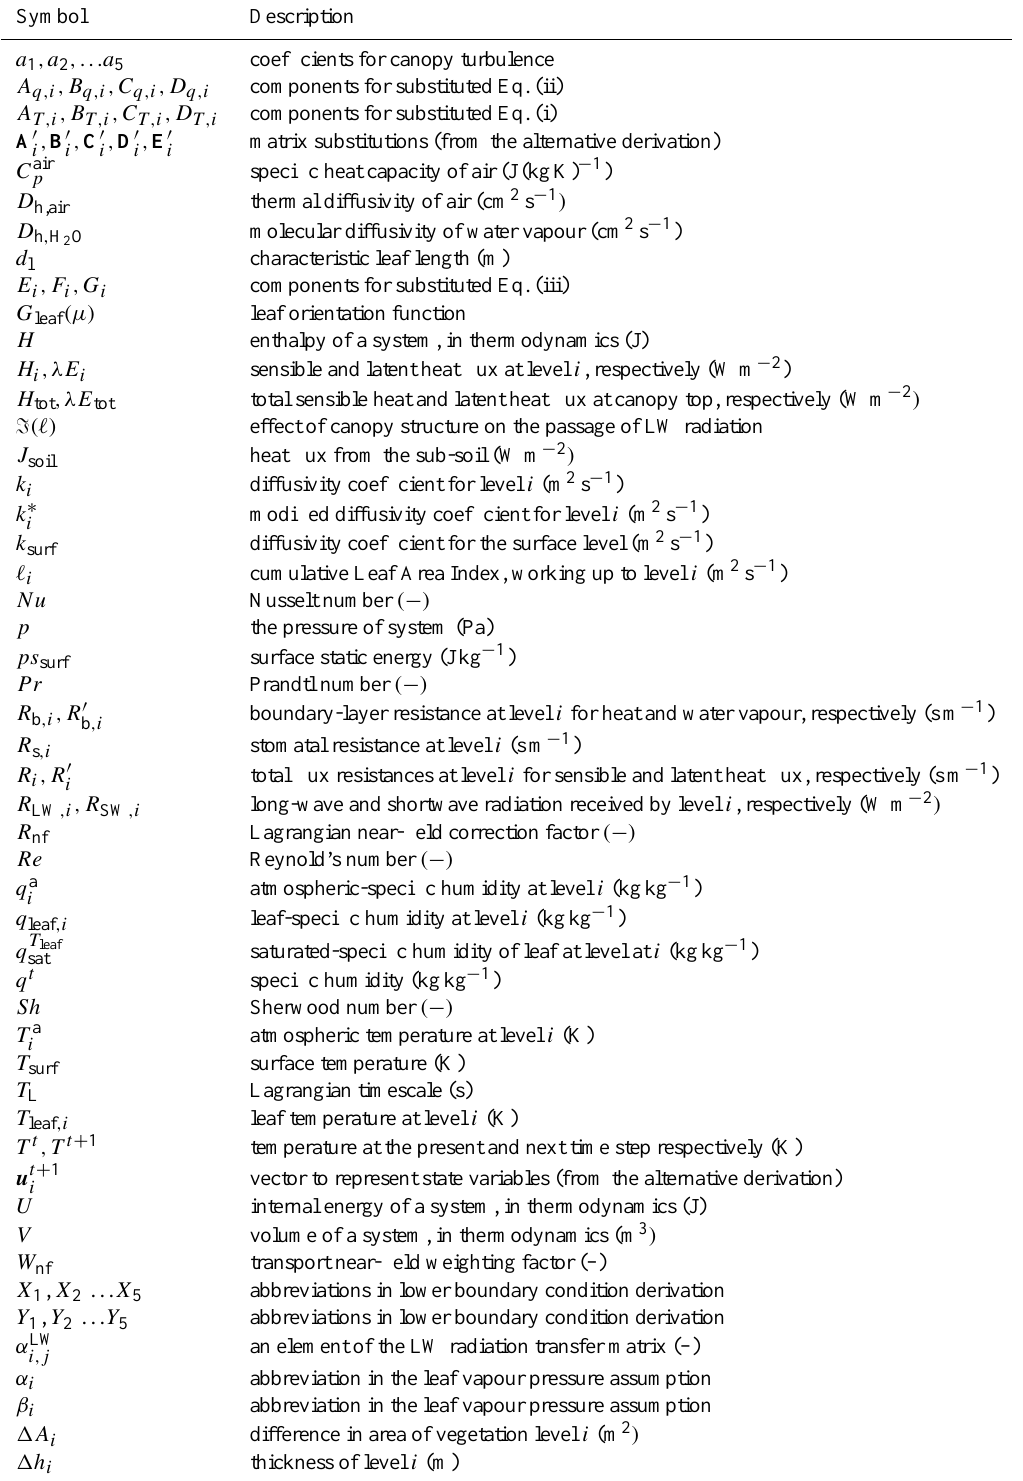
Table 1. Symbolic notation used throughout the